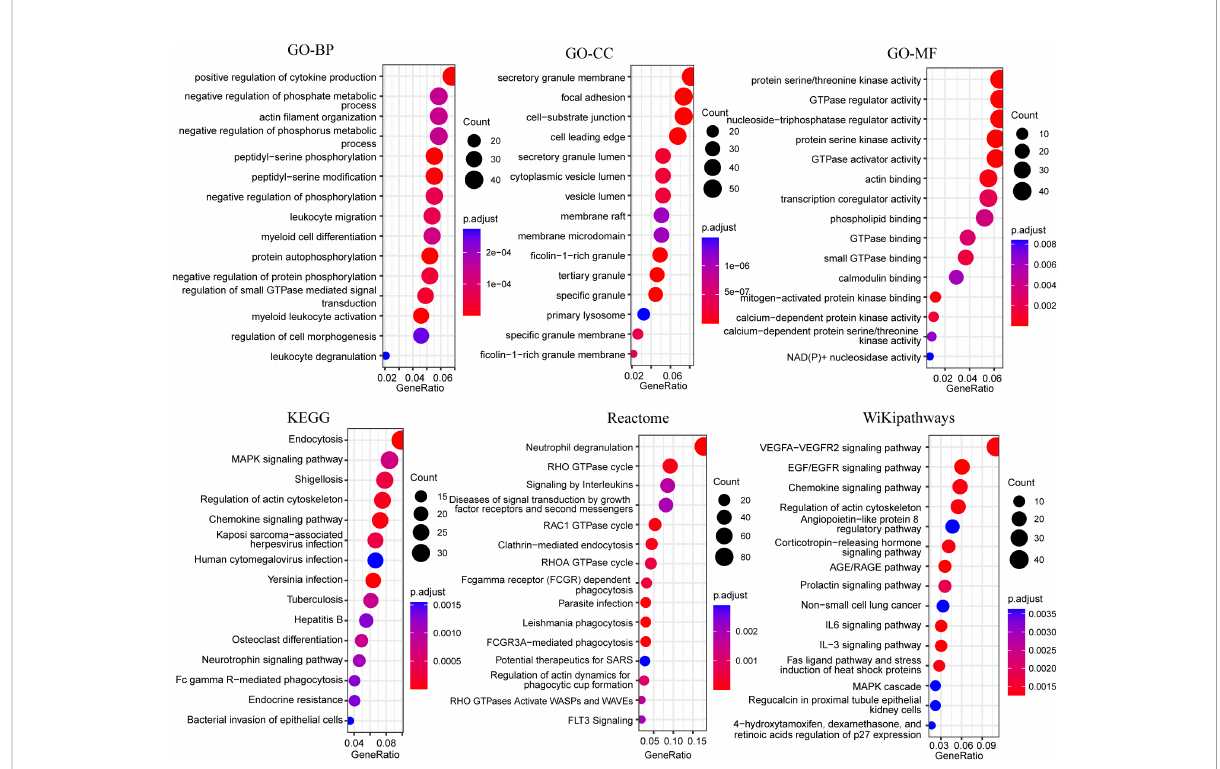
FIGURE 6 Bubble plots of functional enrichment analysis of genes in blue modules, showing only the top 15 signi fi cantly enriched pathways. The color of the bubbles indicates signi fi cance (adjusted P-value), and the size corresponds to the count of genes with corresponding